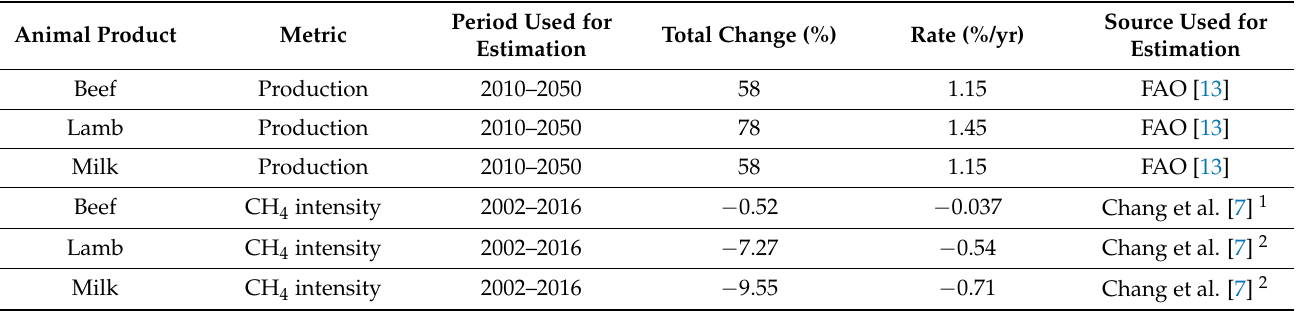
Table 1. Estimated rates of change in production and methane (CH 4 ) intensity of beef, lamb, and milk between 2010 and